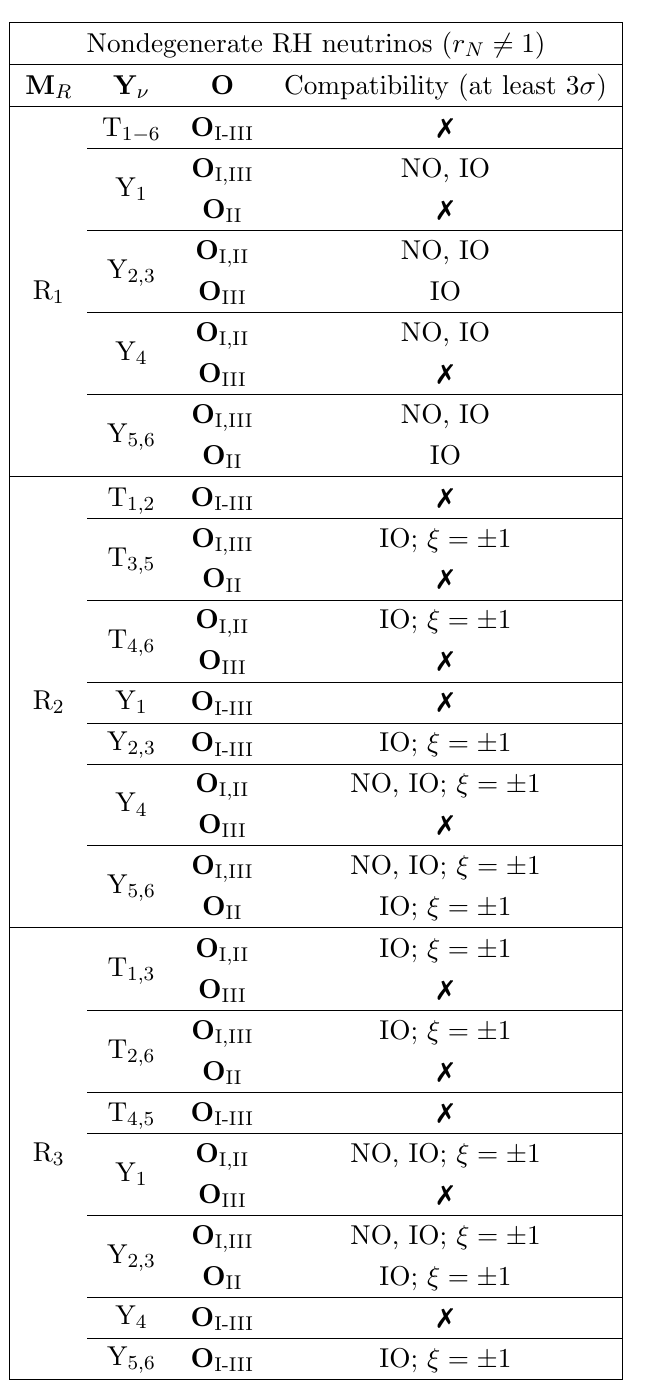
Table 7 . Compatibility summary for the 2RHNSM in presence of the remnant CP symmetry de(cid:12)ned in eqs. (2.13) and (2.14). All cases with Y (cid:23) of the type Y 1 (cid:0) 6 or T 1 (cid:0) 6 , M R of the forms R 1 (cid:0) 3 , and nondegenerate heavy Majorana neutrinos are indicated. The compatibility for the R 2 ; 3 cases is veri(cid:12)ed for at least one value of r N .